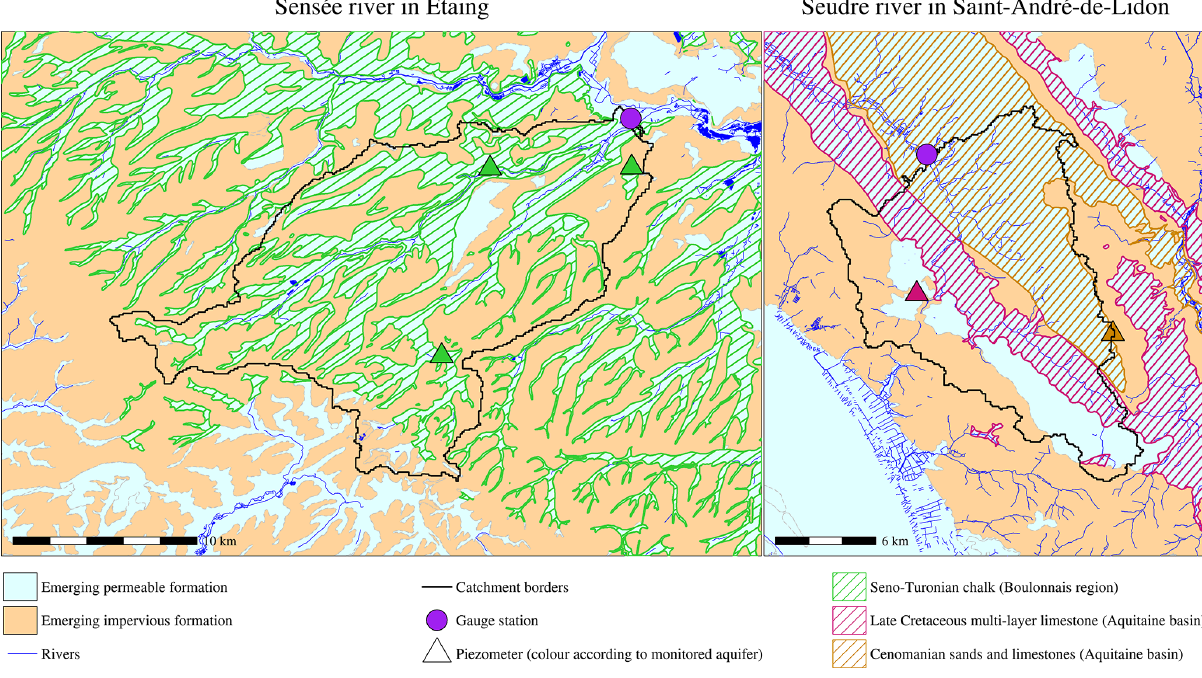
Figure 2. Two examples of hydrogeological maps of catchments used for dataset selection. Their locations in the French mainland territory are shown in Fig.